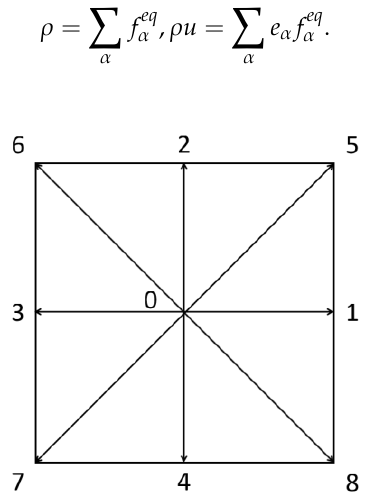
Figure 1. The two dimensional and nine velocity (D2Q9) model.